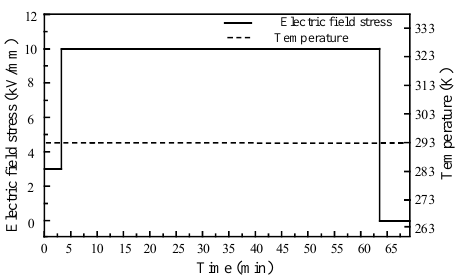
Figure 6. The temperature and electric field stress of pressboards varying with time on the pulsed electro-acoustic (PEA) system.